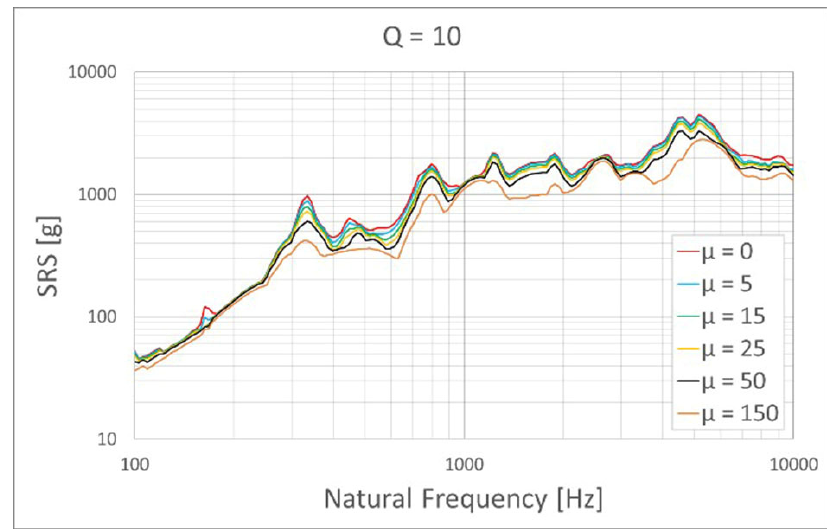
Figure 6. The effect of mass proportional damping on the SRS curves.